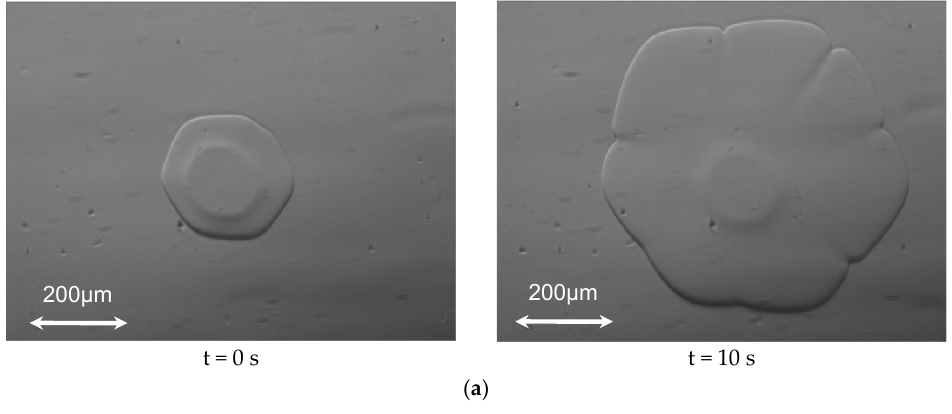
Table 1. Image-capturing